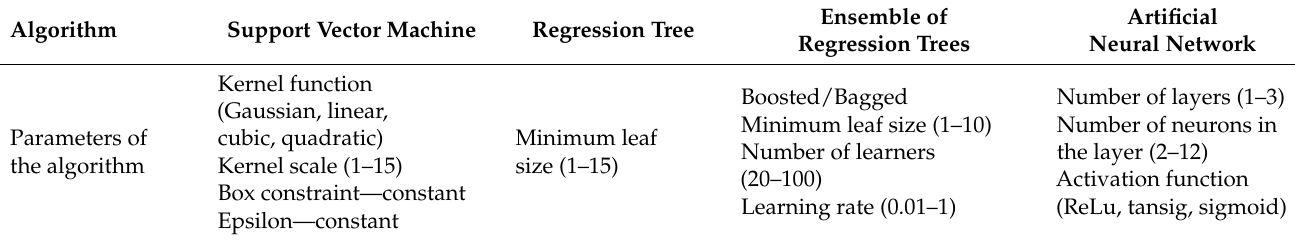
Table 4. Studied models’